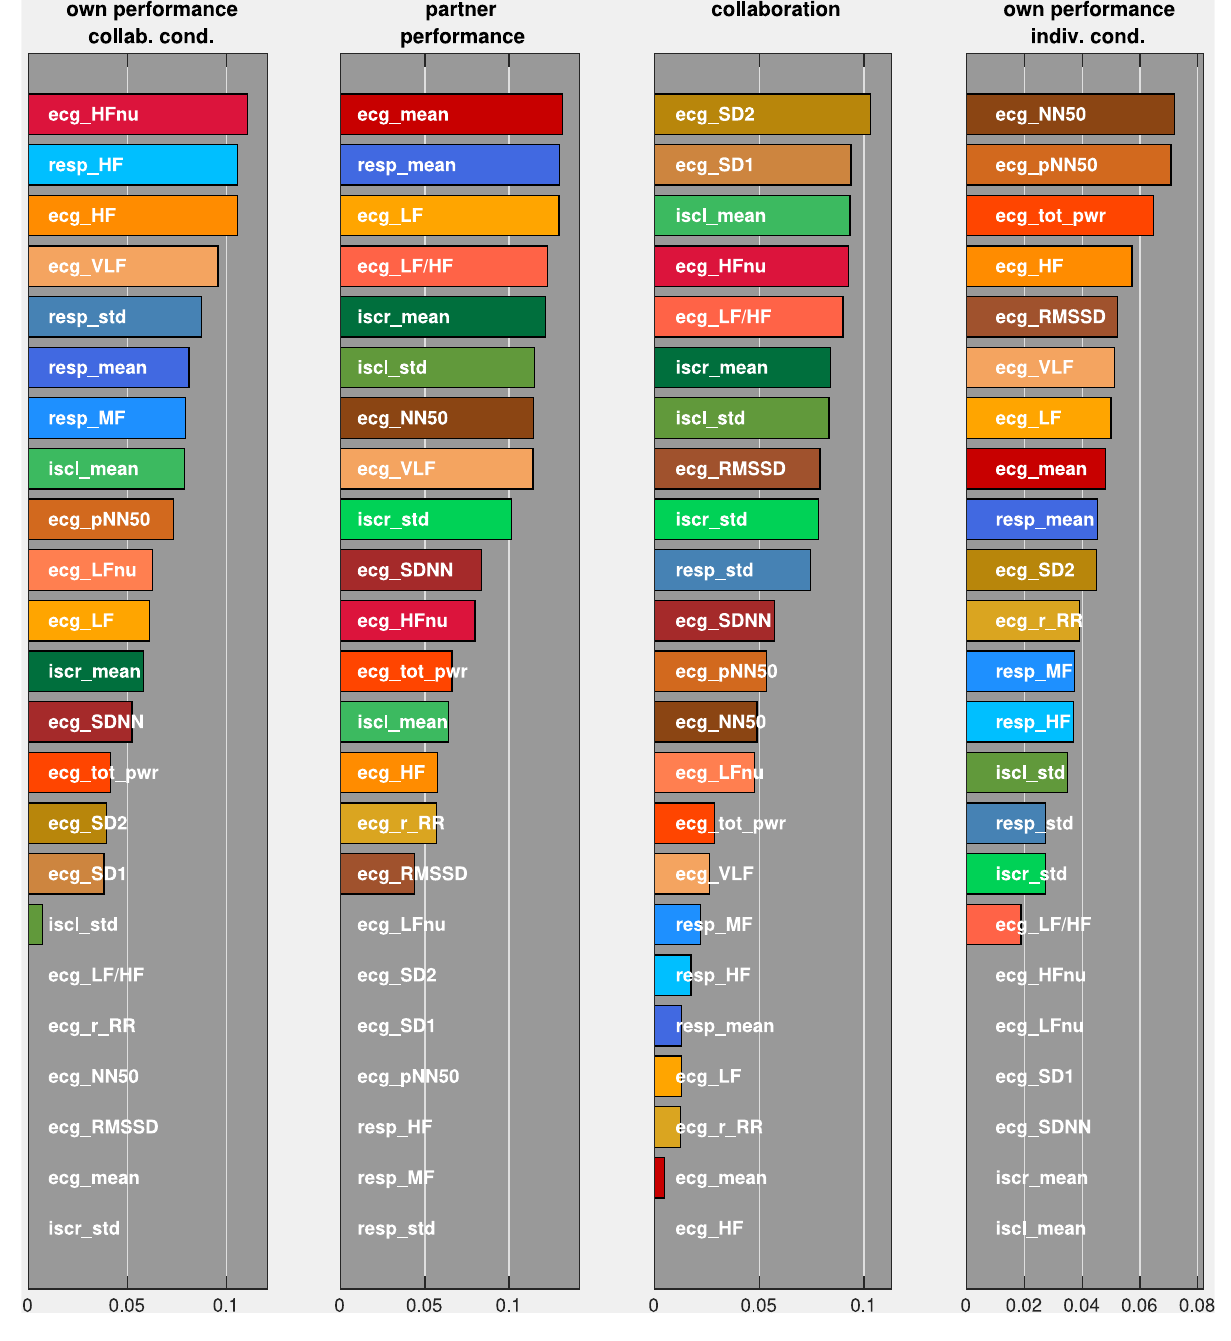
stronger coupling between ratings and these parameters in the collaborative condition suggests that subjects rely more on the internal state of their body when assessing the outcome in a collaborative